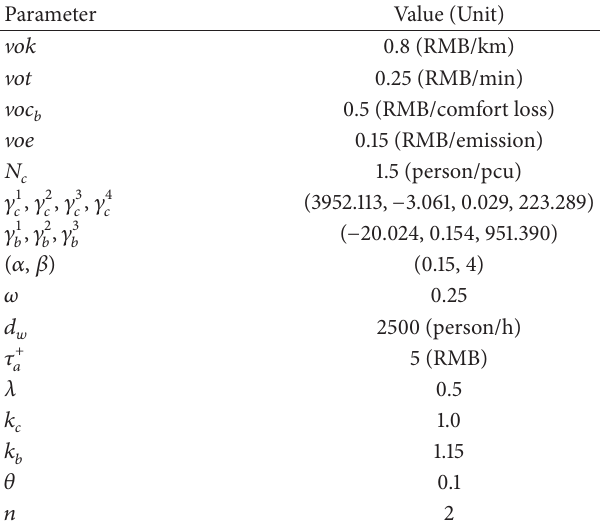
Table 5: Normal value of the numerical